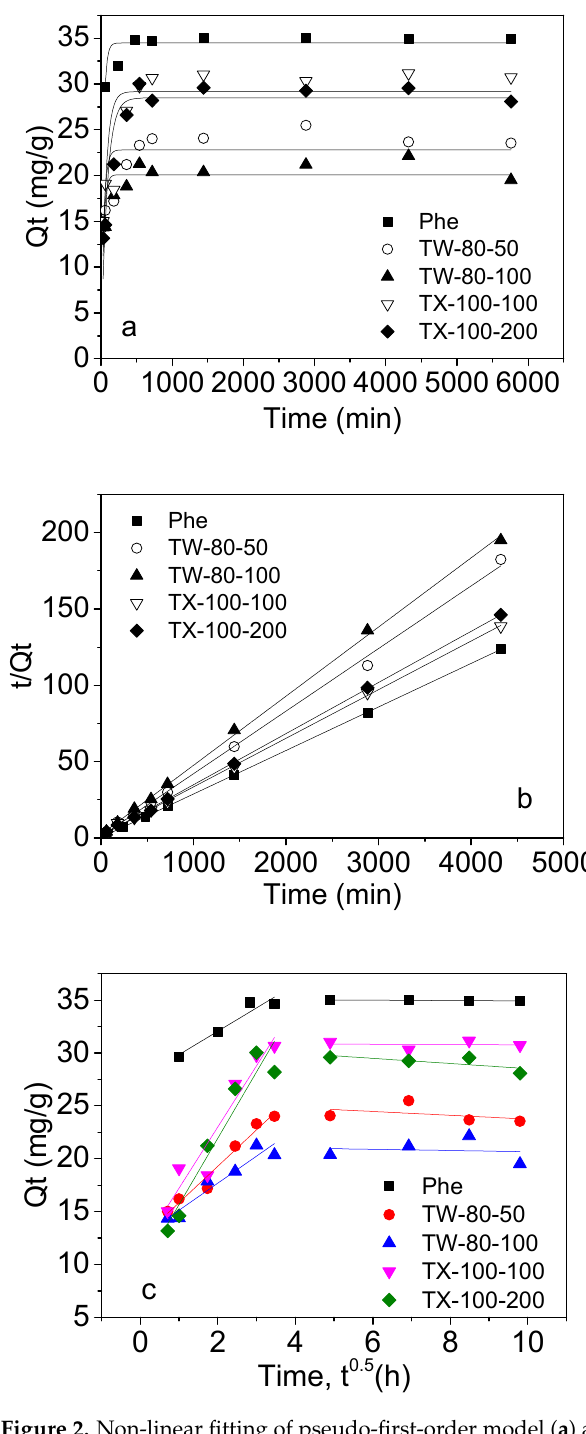
Figure 2. Non-linear fitting of pseudo-first-order model ( a ) and pseudo-second-order model ( b ), and plots of Weber – Morris diffusion model ( c ) for the adsorption of phenanthrene onto MWCNTs. In general, the removal mass for Phe using MWCNTs as affected by surfactants was in the order MWCNTs > TX-100-100 + MWCNTs > TX-100-200 + MWCNTs > TW-80-50 + MWCNTs > TW-80-100 + MWCNTs. Therefore, the TW-80 more seriously prevented the Phe from being adsorbed onto MWCNTs than TX-100. The adsorption mechanisms and the potential rate-controlling step were evaluated using the kinetic models. The theoretical Q Equation values for Phe that were calculated from